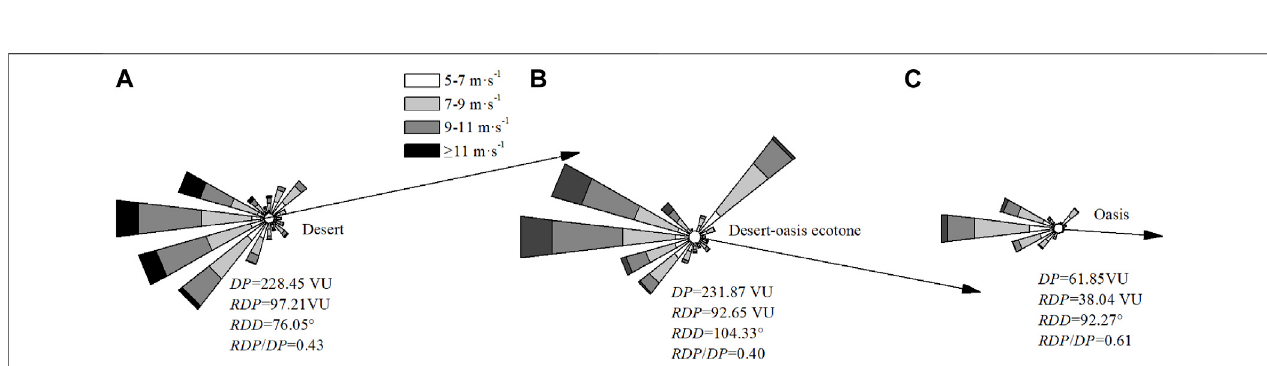
Frontiers in Environmental Science |